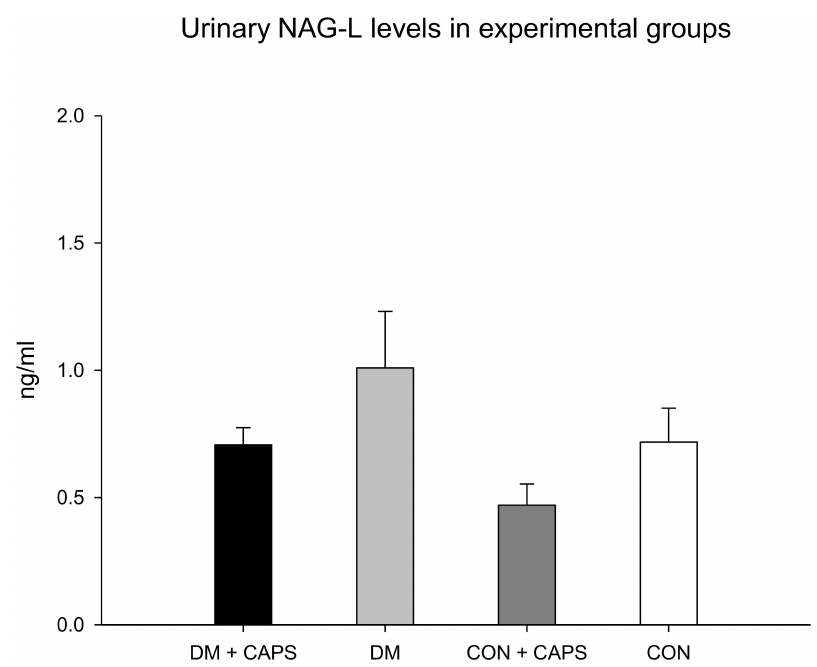
Figure 6. Effect of 8 weeks of capsaicin administration (1 mg/kg/day) on urinary NAG-L levels. NAG-L: Neutrophil-gelatinase associated lipocalin. Data are mean ±